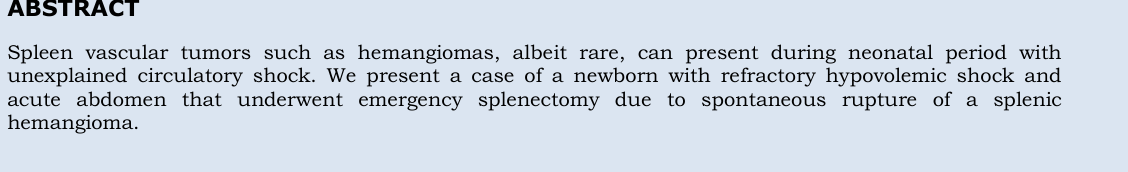
hemoperitoneum and a laceration of the spleen at its lower pole (Fig. 1). Splenectomy was performed.